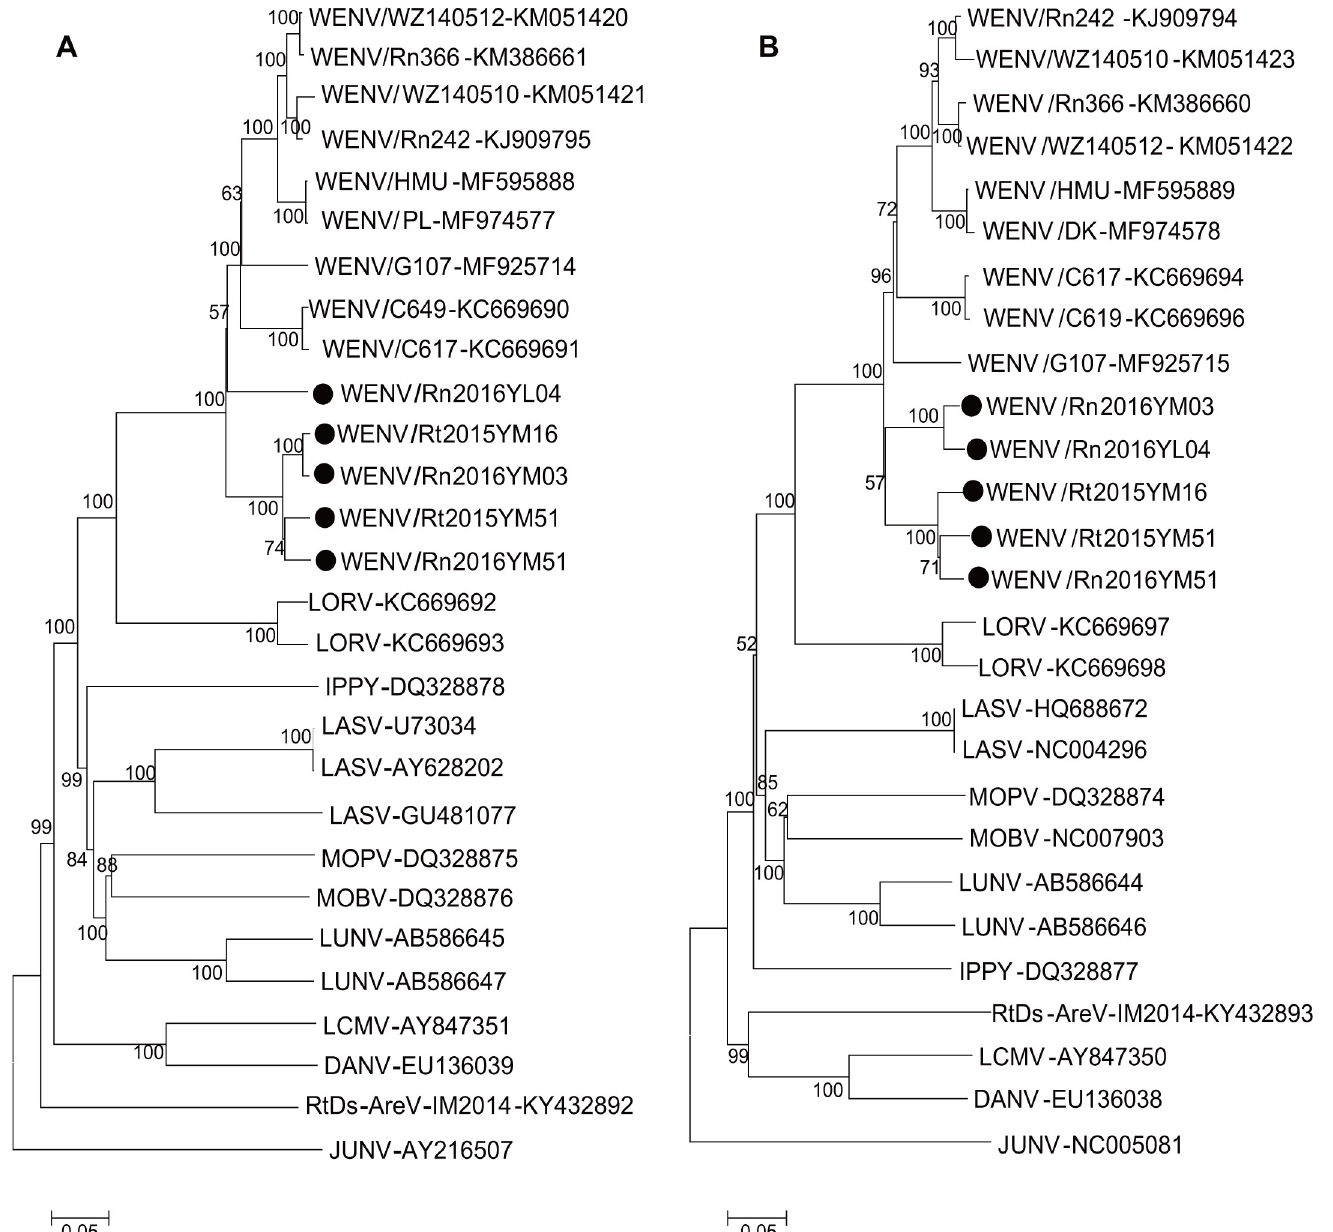
Fig 3. Phylogenetic analysis of mammarenavirus genomes obtained in this study. The neighbor-joining tree was constructed with MEGA 7 software based on the alignment of complete L segment (A) and S segment (B) sequences of mammarenaviruses detected in this study, and representative mammarenaviruses. Bootstrap values were 1,000. New genome sequences obtained in this study are indicated with a black